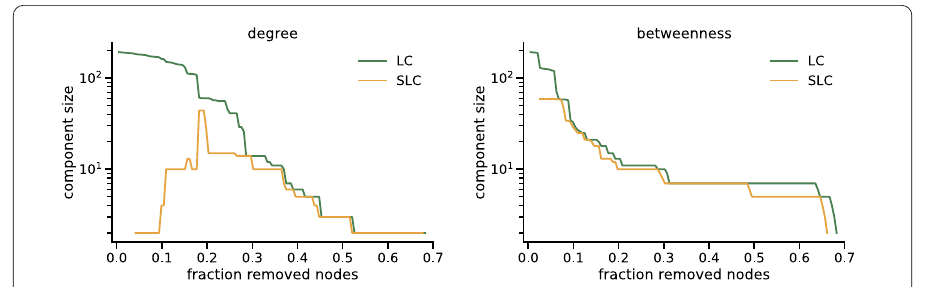
Figure 4 Size of the largest LC q (green) and second largest SLC q (orange) connected component as a function of the percentage q of removed nodes. In the left panel nodes are removed starting from those who have the highest degree. In the right panel nodes are removed starting from those who have the highest